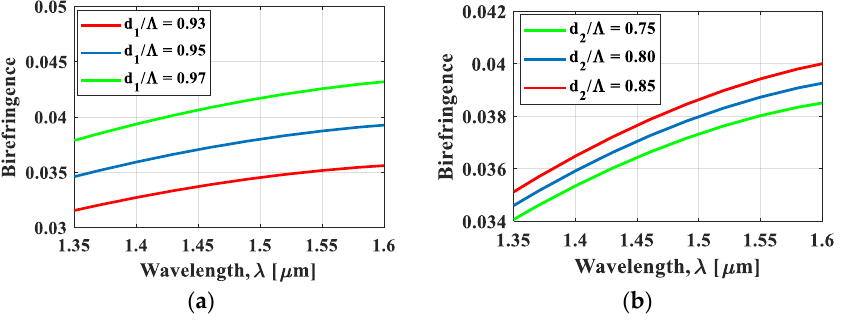
Figure 3. Effect of changing ( a ) d 1 / Λ on the birefringence characteristics, when the remaining parameters ( Λ = 0.76 and d 2 / Λ = 0.80) were kept constant; and ( b ) d 2 / Λ on the birefringence characteristics, when the remaining parameters ( Λ = 0.76 and d 1 / Λ = 0.95) were kept constant.